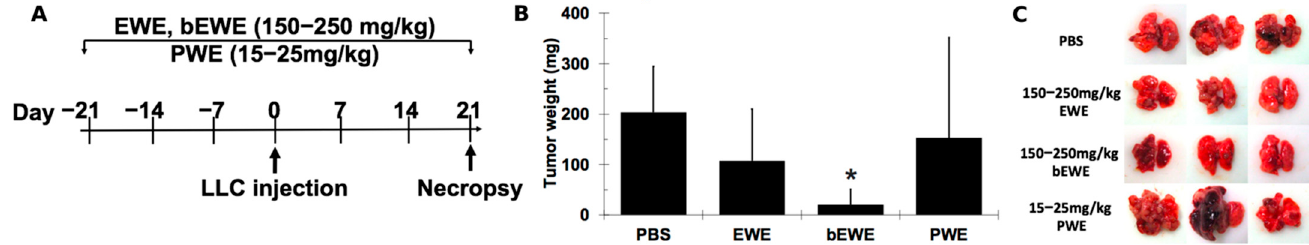
Figure 1. Pre-treatment with Euglena water extract (EWE) and boiled Euglena water extract (bEWE) attenuated growth of Lewis lung carcinoma (LLC) tumors in murine lungs. ( A ) Schematic illustration of the study design. ( B ) Average tumor weight in each treatment group; phosphate buffered saline (PBS) served as a control. ( C ) Macroscopic views of the lungs from LLC tumor-bearing mice in PBS or extract pretreatment groups. The scale bar in each picture represents 5 mm. Results are presented as mean ± SD ( n = 5). *: p < 0.05 as compared to the PBS group. PWE: paramylon water extract.